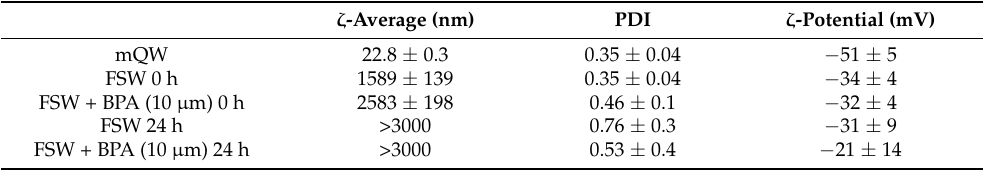
Table 1. ζ -average, polydispersity index (PDI) and ζ -potential measured by Dynamic Light Scattering (DLS) of non-functionalized PS NPs (50 µ g/mL) in mQW, FSW and FSW with BPA (10 µ m), at time 0 (0 h) and after 24 h of incubation (24 h). Values are shown as mean ± standard deviation.